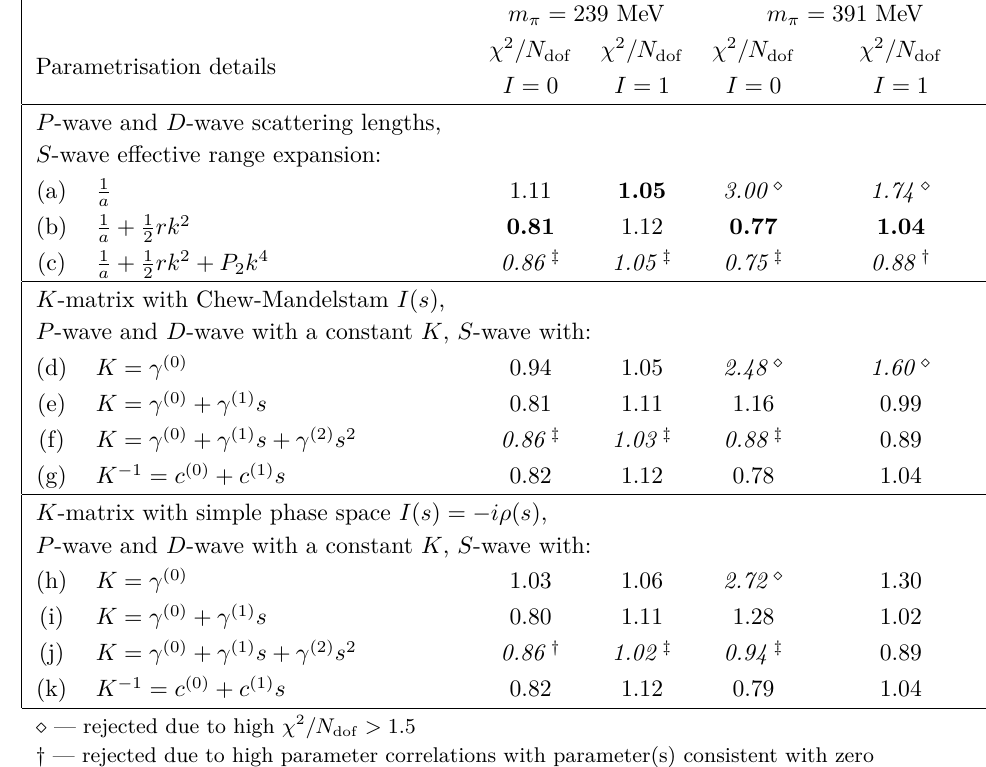
Table 5 . A selection of the parametrisations used for elastic D ¯ K scattering with I = 0 and 1 . The χ 2 /N dof in bold indicate the reference fits which are described in the text. Parametrisations with χ 2 /N dof shown in italics are not considered an acceptable description of the data for the reason given in the